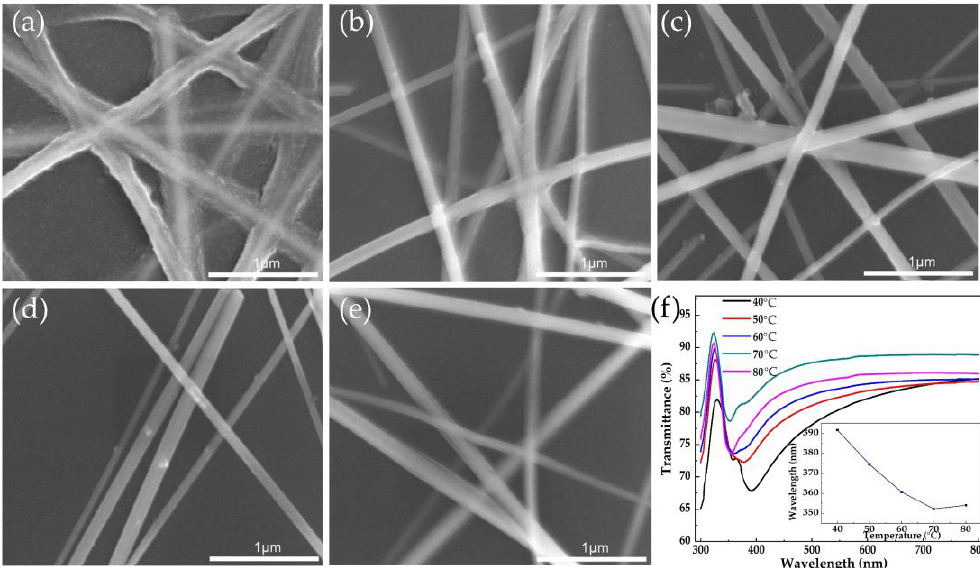
Figure 1. SEM images of AgNWs ’ electrodeposited Al 2 O 3 at different temperatures for 40 s: ( a ) 40 °C, ( b ) 50 °C, ( c ) 60 °C, ( d ) 70 °C, and ( e ) 80 °C. ( f ) UV-visible transmittance spectra of products at different temperatures; inset shows the change of absorption peak with temperature.